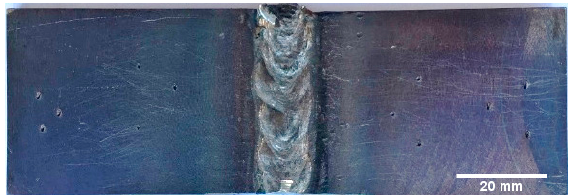
Figure 4. View of a welded experimental sample.